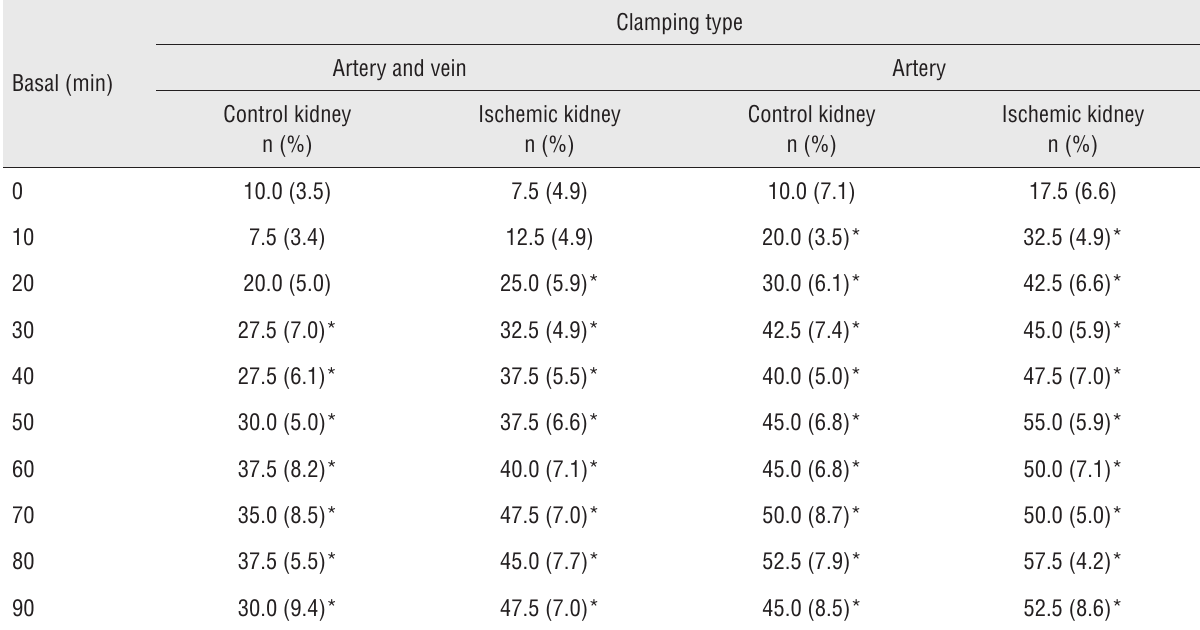
Table 2 - Results of multiple comparisons between moments regarding the presence of lesions using Bonferroni Method with p value